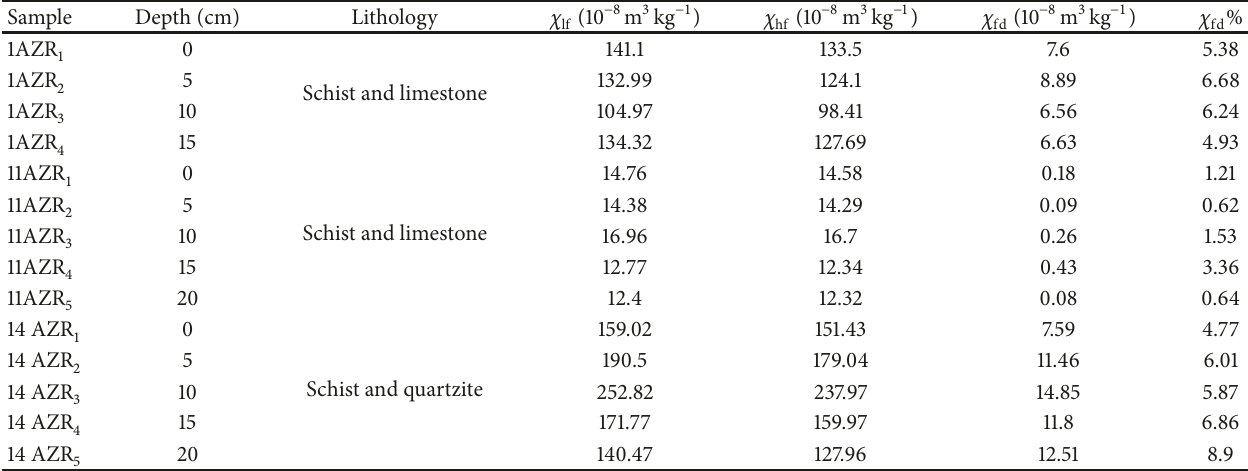
Table 2: Magnetic parameters measured on the different samples of Ait Azzouz reforested land. Sample